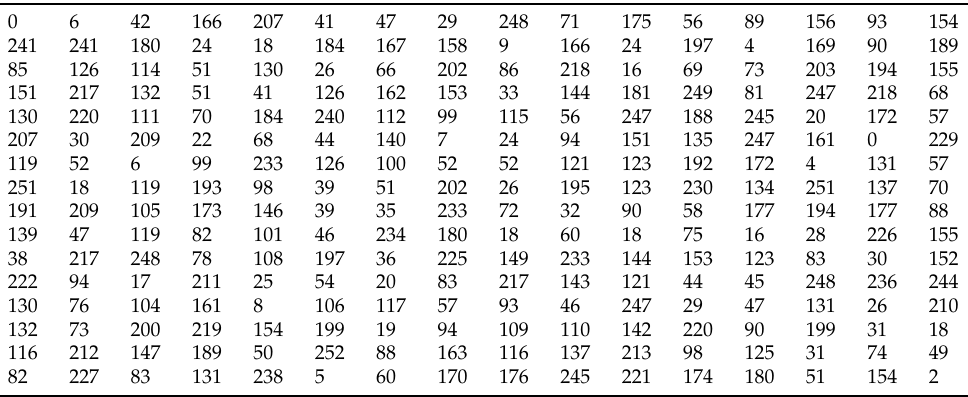
Table 4. The coefficients of the linear polynomial for the proposed